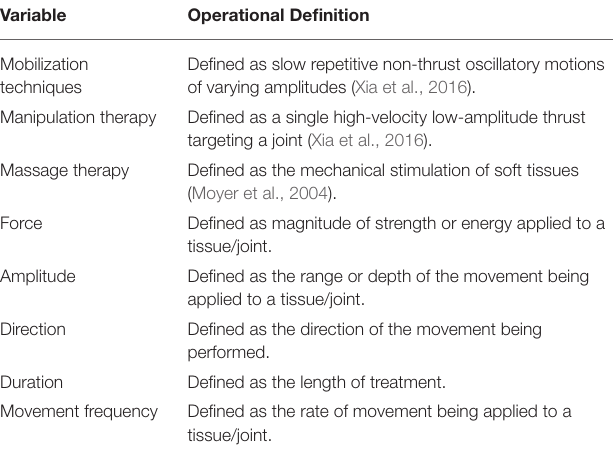
TABLE 1 | Operational